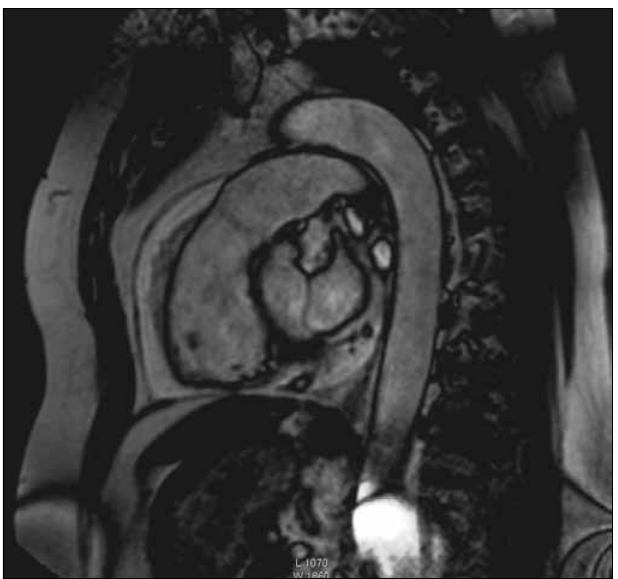
Fig. 4. RVOT bright blood cine BTFE TR=3.4, TE=1.7, Flip=60.